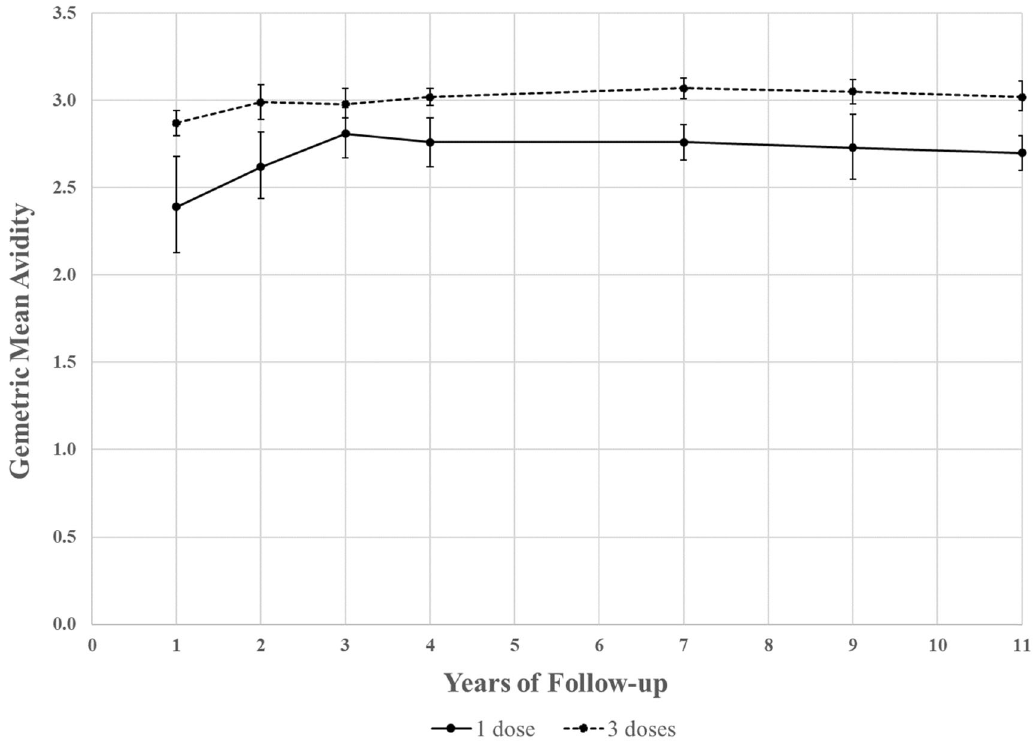
Fig. 1 Antibody avidity over time among participants who were HPV16 seronegative at fi rst HPV vaccination. Dots represent the geometric mean antibody avidity index for the one-dose group (solid line) and the three-dose group (dashed line), and the error bars represent 95% con fi dence intervals (CI). Regression lines are estimated by regressing log(avidity) on either an intercept, an indicator for the second study visit, and/or study year, and reporting on the parameter the parameter 100(e β